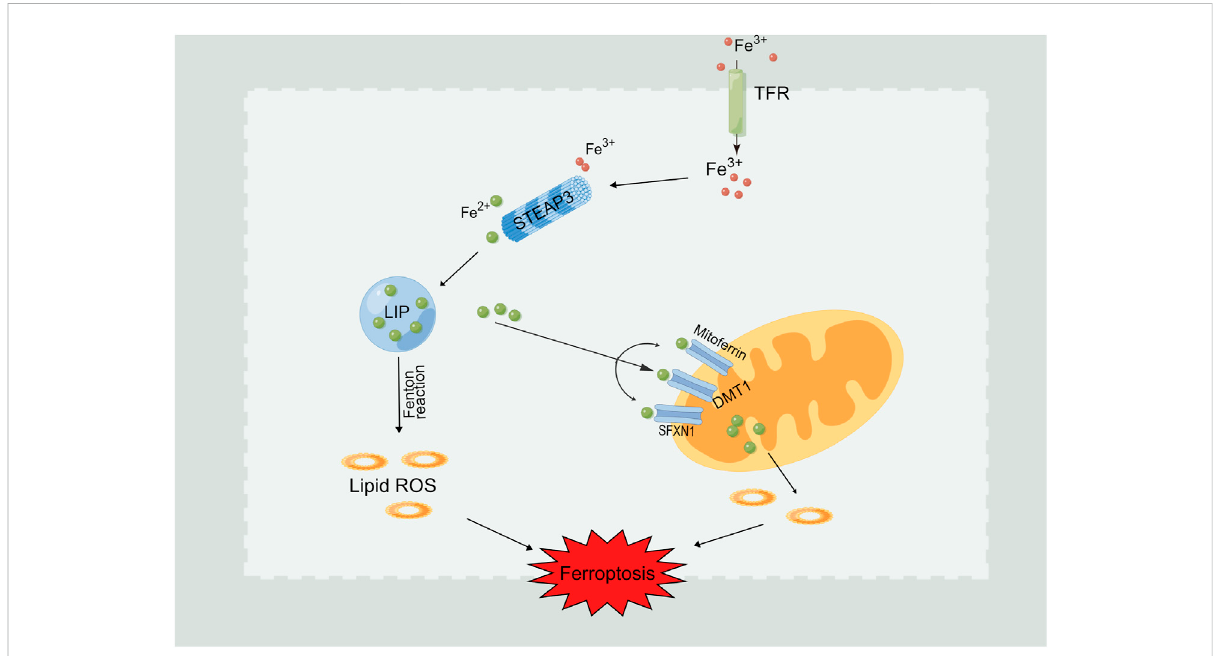
FIGURE 2 Intracellular Fe 2+ overload induces ferroptosis. Fe 3+ fl ows into the cell through the transferrin receptor (TFR). Fe 3+ is reduced to Fe 2+ through prostatesixtimestransmembraneprotein3(STEAP3)andstoredinthelabileironpool(LIP).Fe 2+ canalsobefurtherreleasedfromtheendosomeinto LIP with the assistance of divalent metal transporter 1 (DMT1). Iron boosts the free radicals generation under the effect of Fenton reaction, which further promoting the occurence of lipid peroxidation and ferroptosis